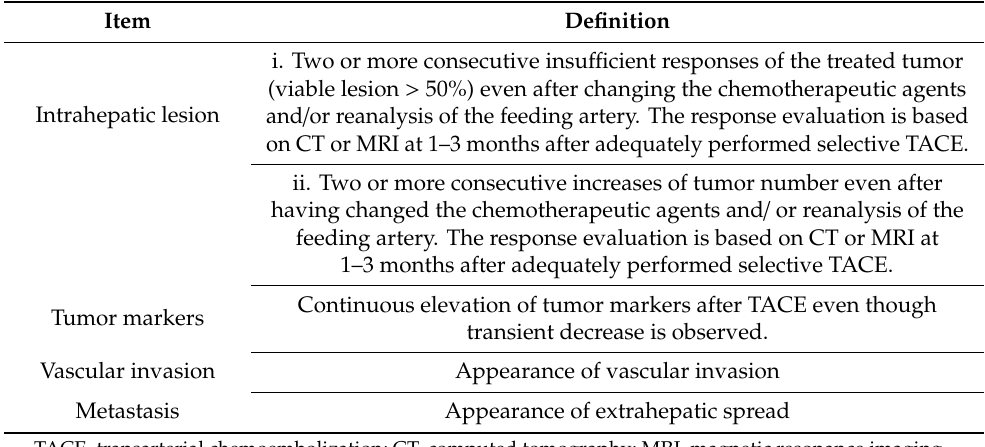
Table 2. Definition of TACE failure / refractoriness by the Japanese Society of